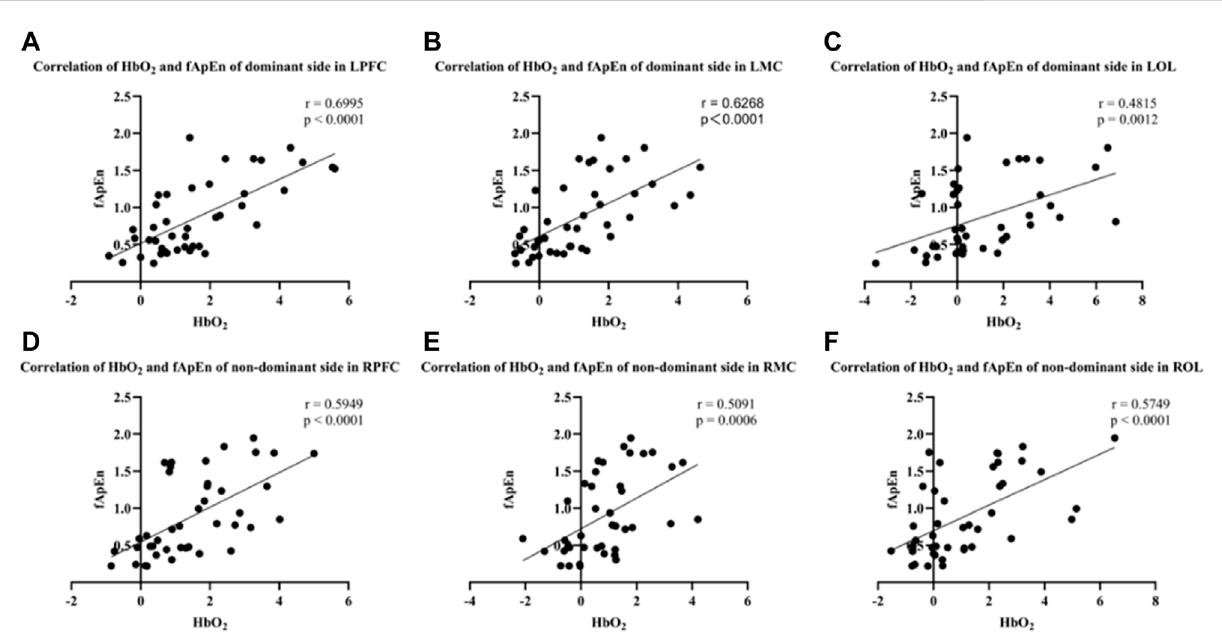
FIGURE 8 (A – C) Correlation of HbO 2 and fApEn of the dominant side in LPFC (r = 0.6995, p < 0.0001), LMC (r = 0.6268, p < 0.0001) and LOL (r = 0.4815, p = 0.0012). (D – F) Correlation of HbO 2 and fApEn of the non-dominant side in RPFC (r = 0.5945, p < 0.0001), RMC (r = 0.5091, p = 0.0006) and ROL (r = 0.5749, p <